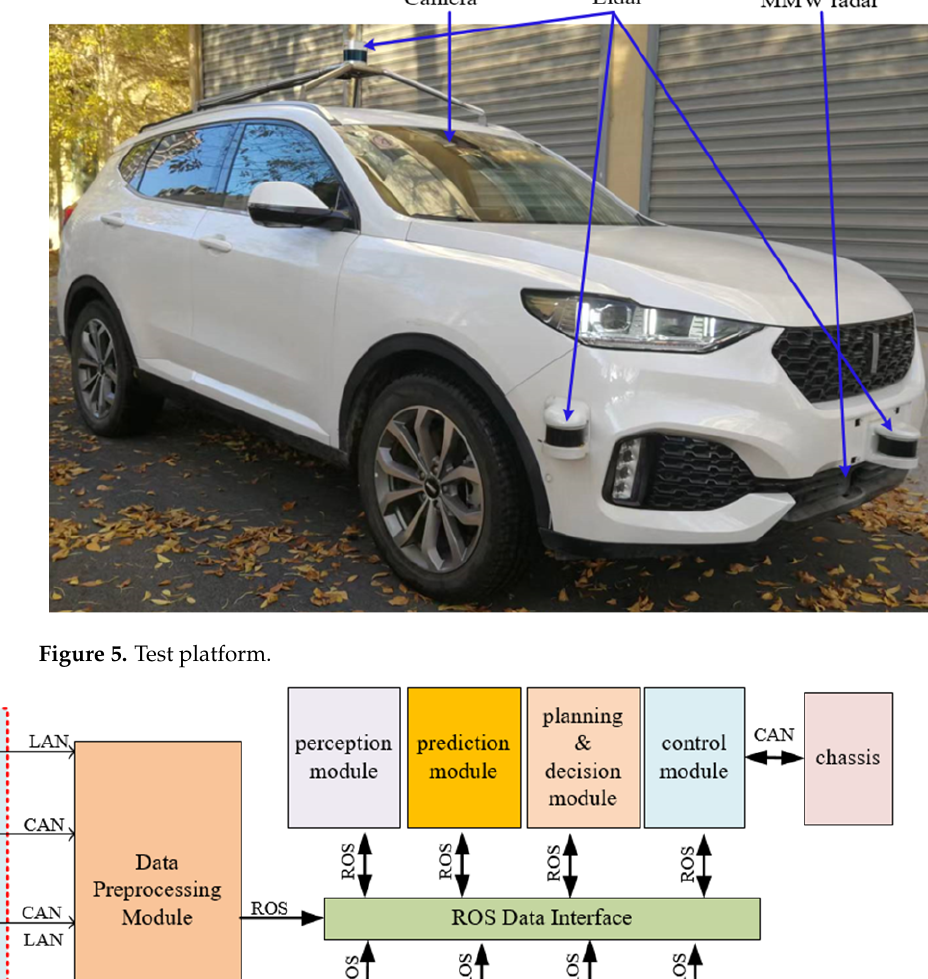
Figure 6. Software architecture. Figure 6. Software